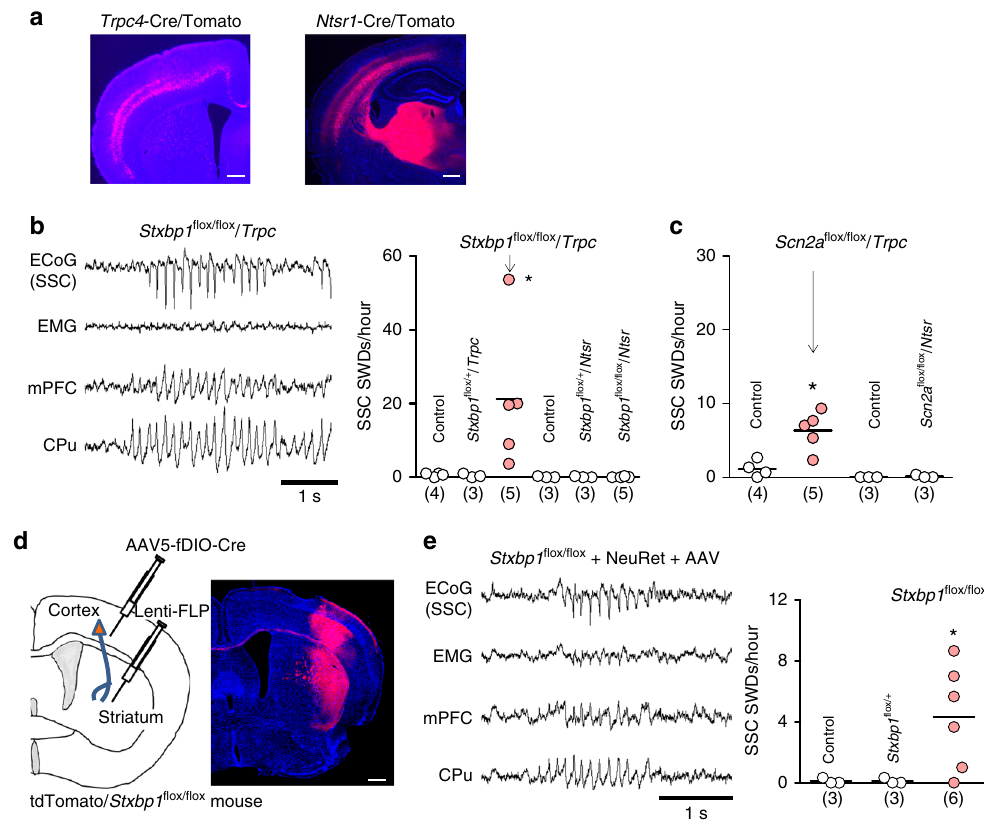
Fig. 4 Stxbp1 deletions in cortico-striatal but not cortico-thalamic projection neurons causes SWDs. a (Left) Trpc4 -Cre dependent tdTomato (red) expression in neocortical layer 5 and the striatum (coronal section). (Right) Ntsr1 -Cre dependent tdTomato expression (red) in neocortical layer 6 and